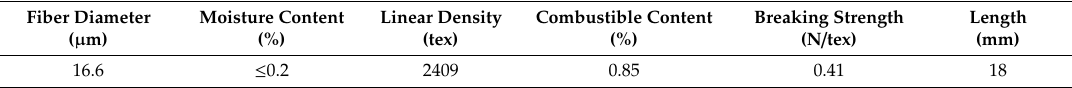
Table 3. Short cut basalt fiber performance index.